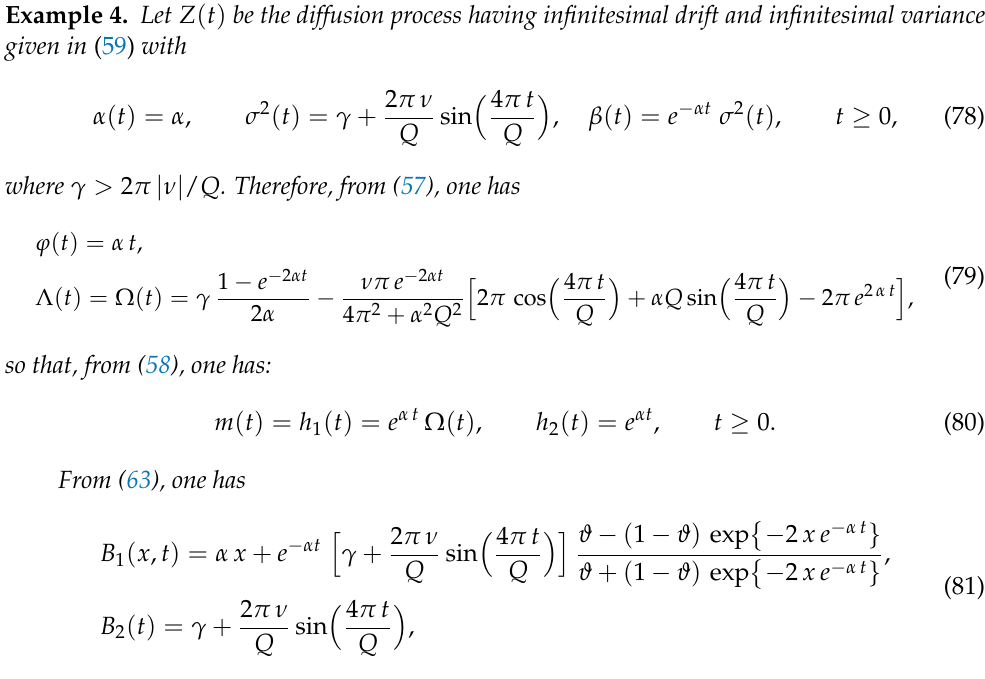
Figure 8. Histograms of FPT through the boundary S for the process Z ( t ) , given in (43), with ϑ = 1, β = 1.5, σ 2 = 2, are compared with the FPT densities (solid curve) of the Ornstein–Uhlenbeck process from Z ( 0 ) = 0 through S = − β / α